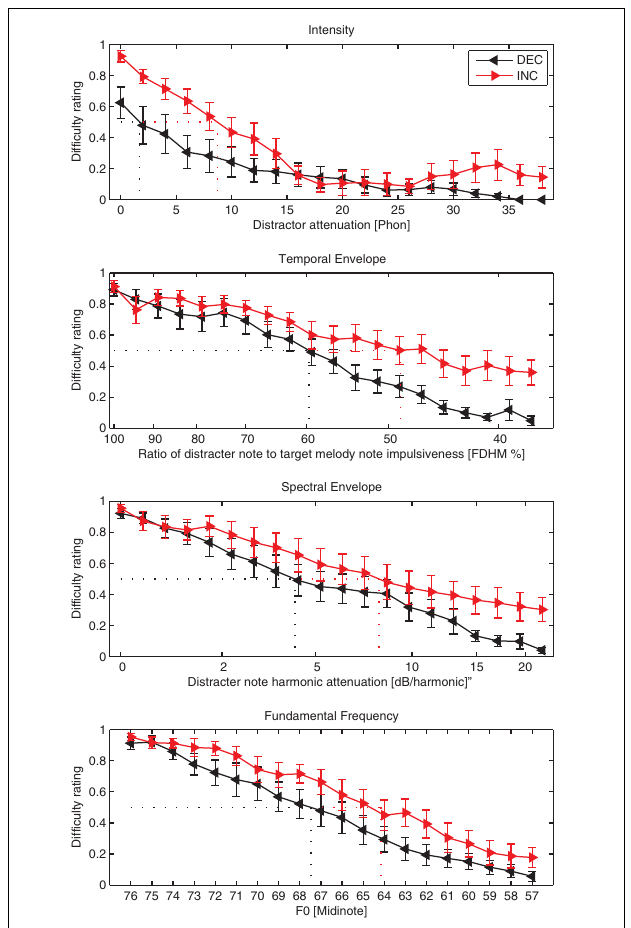
FIGURE 3 | Mean difficulty ratings as a function of the acoustic parameter in Experiment 1.